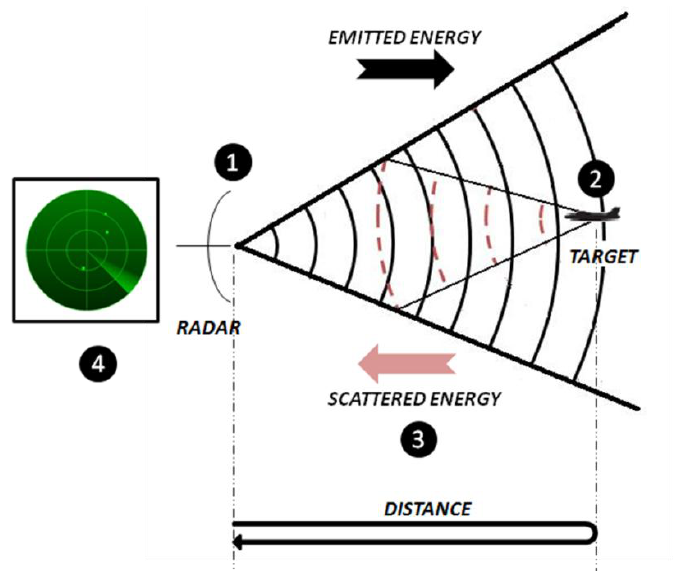
Figure 1. Basic principle of a radar